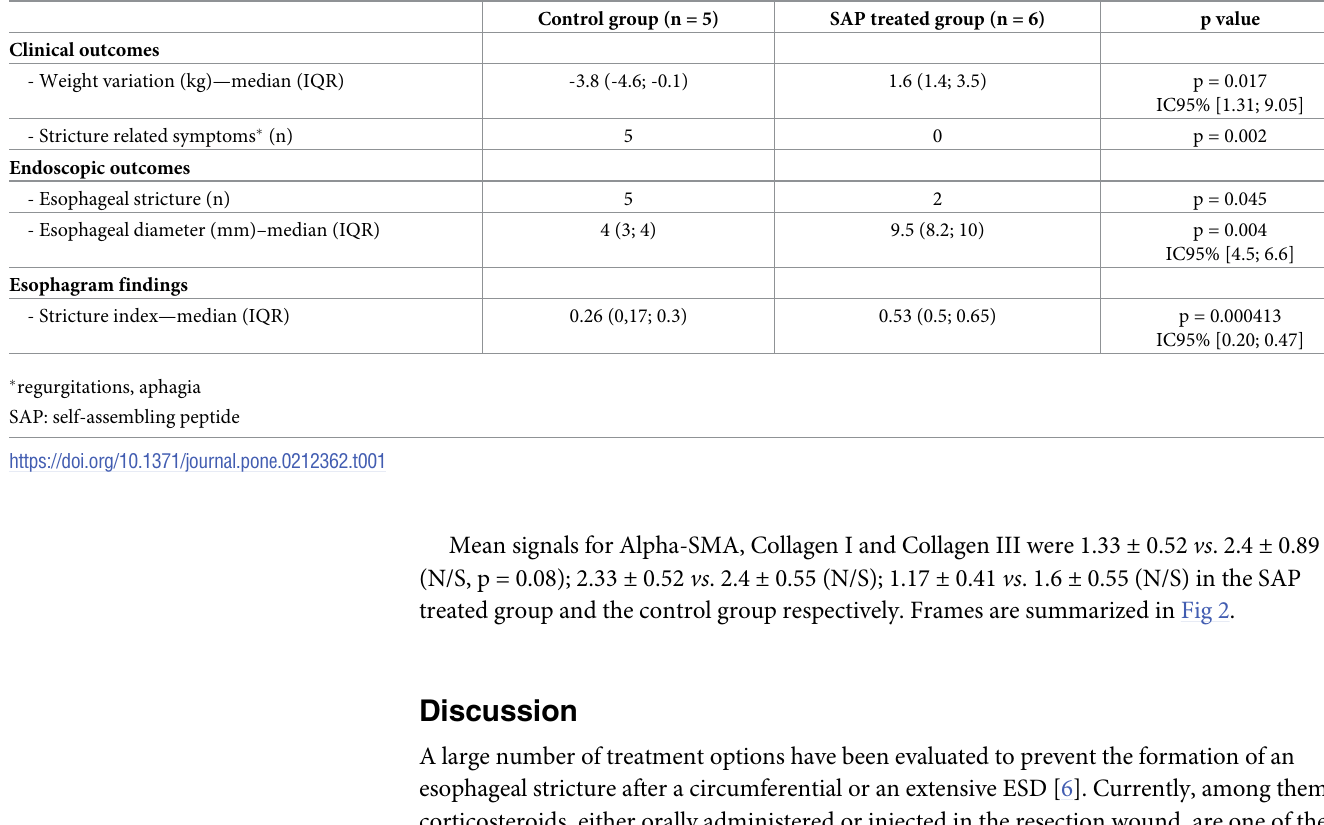
Table 1. Clinical and endoscopic outcomes in the SAP treated and control groups at day 14 after esophageal circumferential endoscopic submucosal dissection.